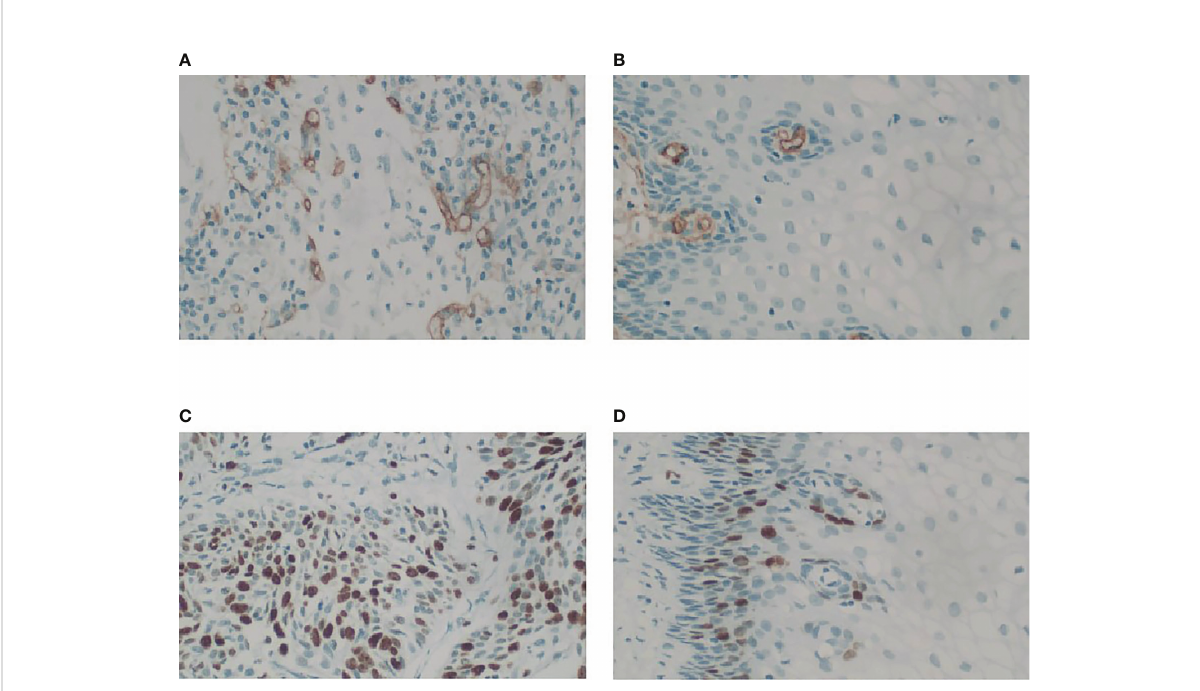
FIGURE 3 Microphotograph showing MVD and Ki-67 PI in cervix cancer mass and the normal tissue for stage IIb cervix cancer in Center 1 (GE 750). (A) Magni fi cation (×40) of one of the hot spots in cervix cancer reveals a high histological microvessel density. (B) Magni fi cation (×40) of one of the hot spots in normal cervix tissue reveals a low histological microvessel density. (C) Immunostain of a cervix cancer for Ki67 showing labelling of roughly 70% of nuclei, 40×. (D) Immunostain of the normal cervix tissue for Ki67 showing positive expression is located in the base, 40×.